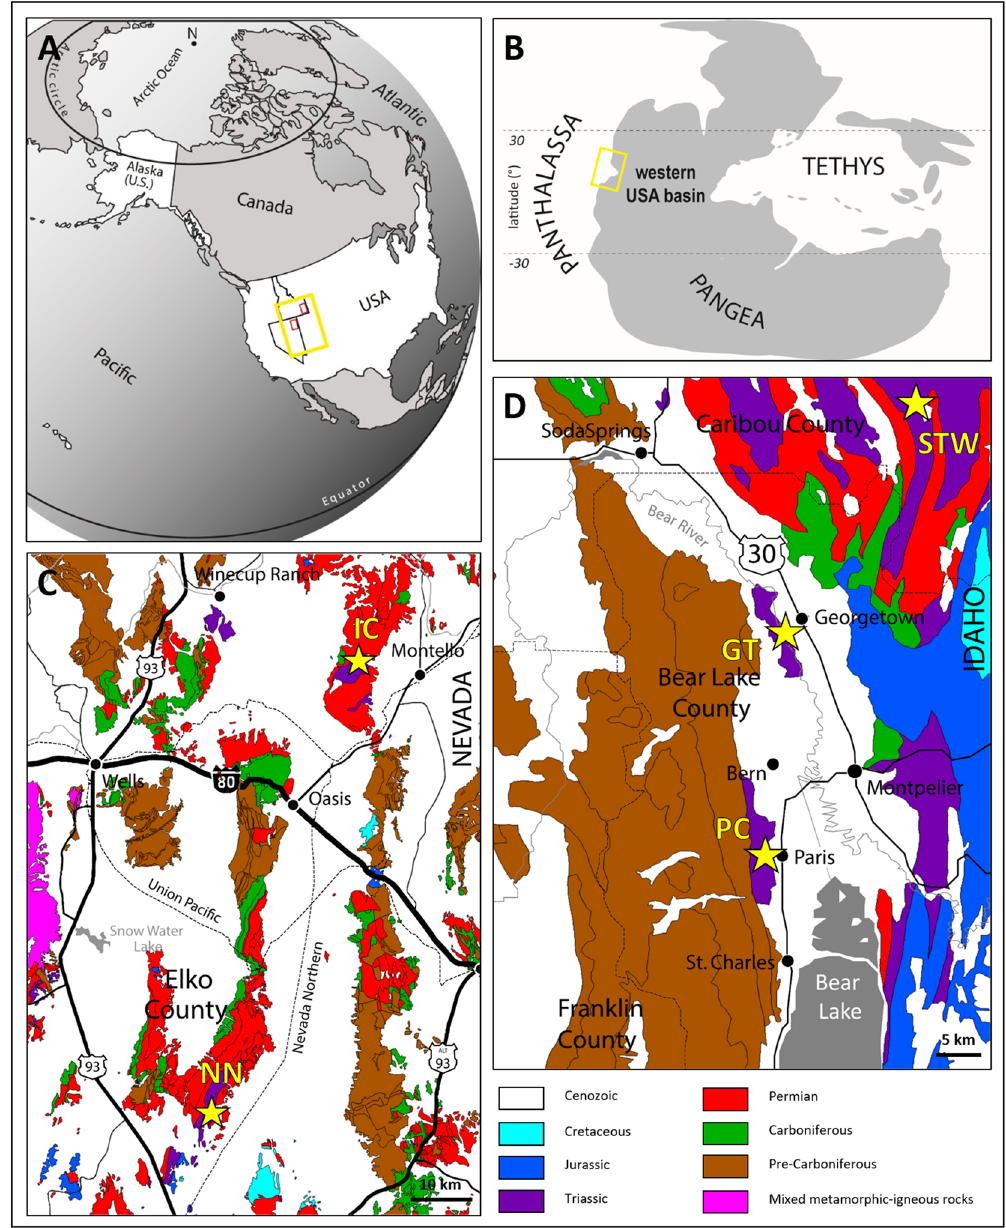
Figure 1. Present-day ( A ) and Early Triassic ( B ) maps showing the position of the western USA basin (yellow rectangles). Simplified geological map of north-eastern Nevada ( C ) and south-eastern Idaho ( D ). Small red rectangles in ( A ) indicate the locations of maps ( C ) and ( D ). Yellow stars indicate locations of studied sites. IC: Immigrant Canyon; NN: NoName; STW: Stewart Canyon; GT: Georgetown; PC: Paris Canyon, original site of the Paris Biota. Maps modified using Adobe Illustrator (v. 25.4.1), following Romano 54 and Horton 55